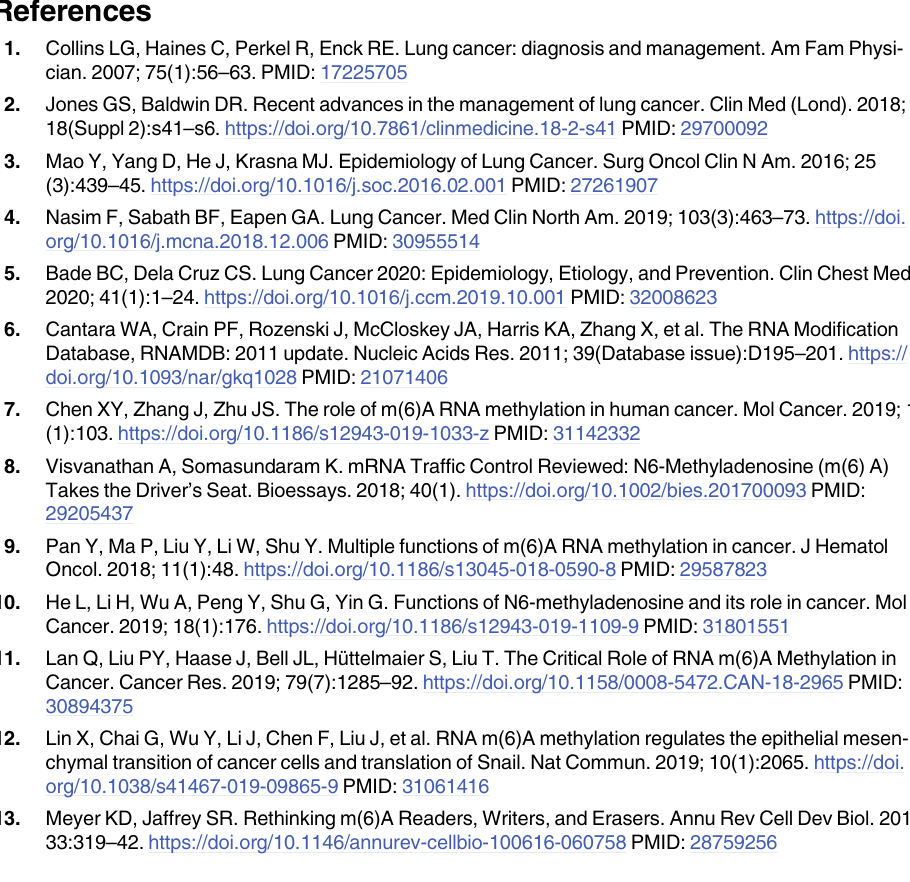
S5 Table. The changes of m 6 A